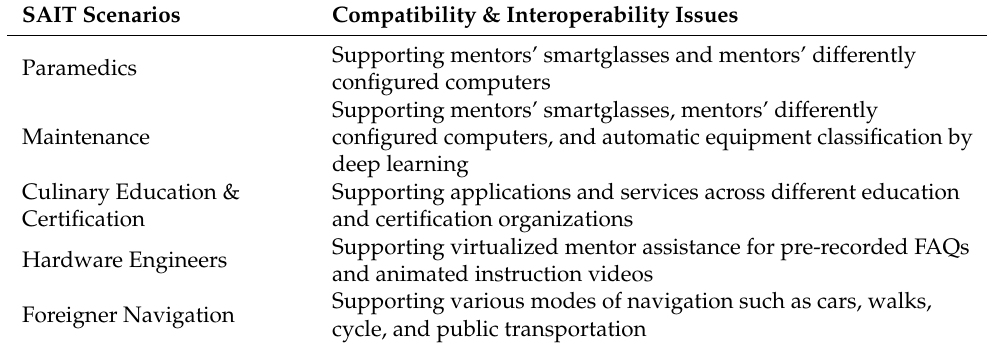
Table 11. Compatibility & interoperability issues in SAIT